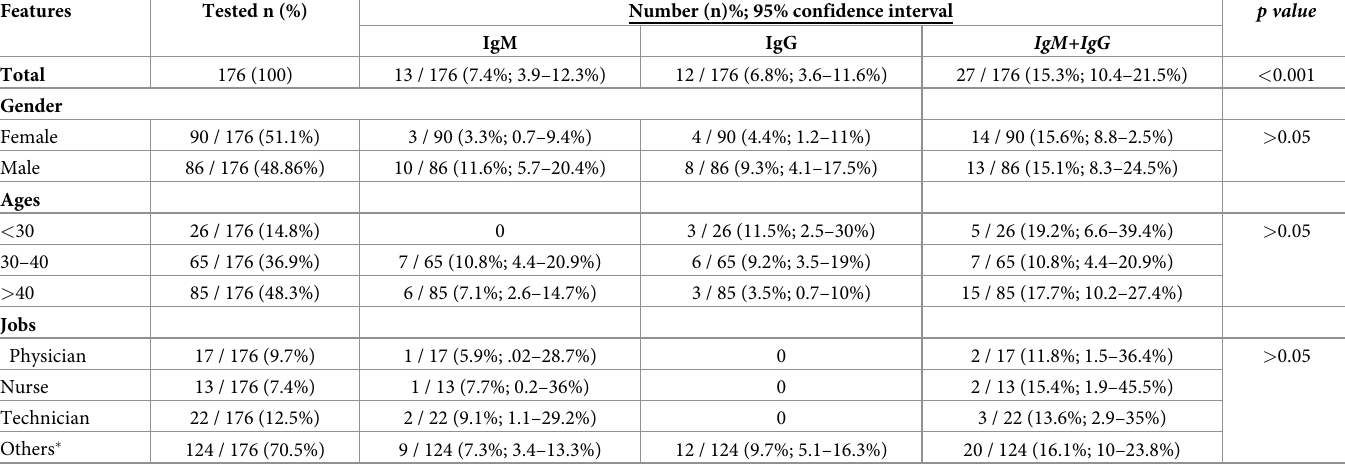
Table 2. The results of electrochemiluminescence immunoassay in tested HCWs according to gender, age groups, and job type. Features